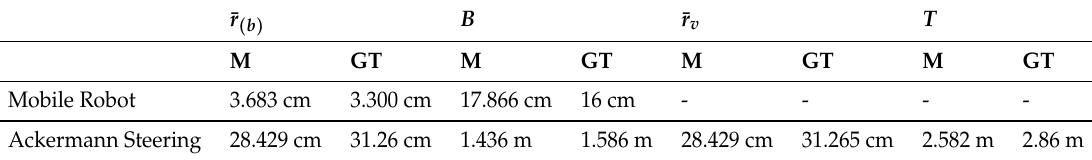
Table 3. Summarized results based on the blackbox model Bayesian neuronal networks of vehicle parameters from the sGP motion models (M) and simulated ground truth (GT). For mobile robot experiments, 15 hidden neurons were used in the hidden layer. For Ackermann steering experiments, 40 hidden neurons were used. ¯ r ( b ) B ¯ r v T M GT M GT M GT M GT Mobile Robot 3.683 cm 3.300 cm 17.866 cm 16 cm - - - - Ackermann Steering 28.429 cm 31.26 cm 1.436 m 1.586 m 2.86